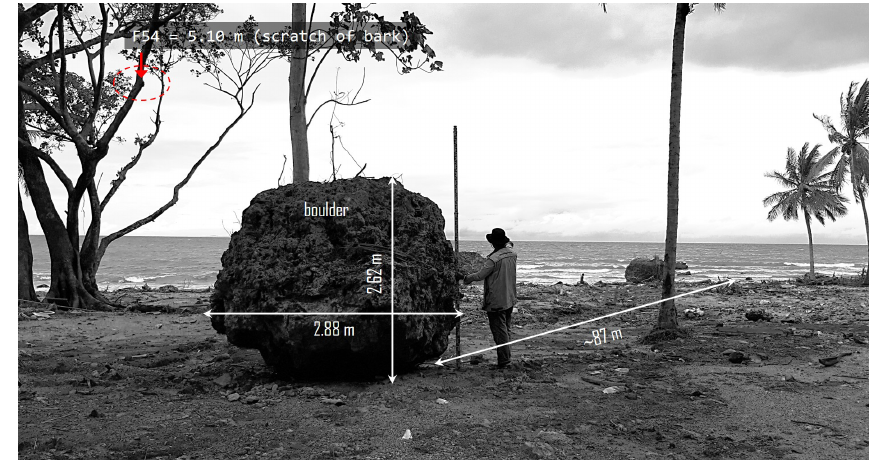
Figure 8. The largest boulder found in Cipenyu Beach of Banten was transported about 87m from its original place. An arrow shows the estimated transport direction of the boulder with an estimated velocity of 4.37ms − 1 , captured on 28 December 2018.